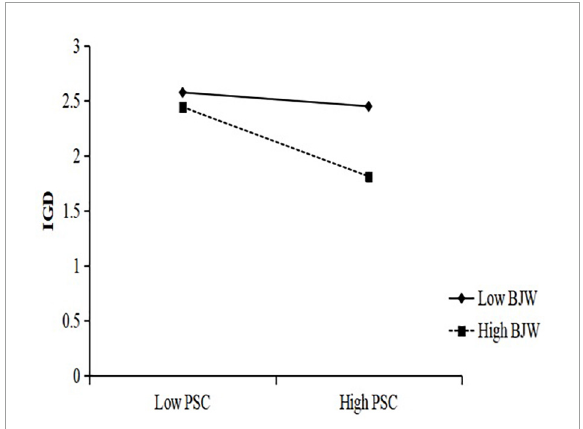
FIGURE4 The moderating effect of belief in a just world on maladaptive cognition to internet gaming